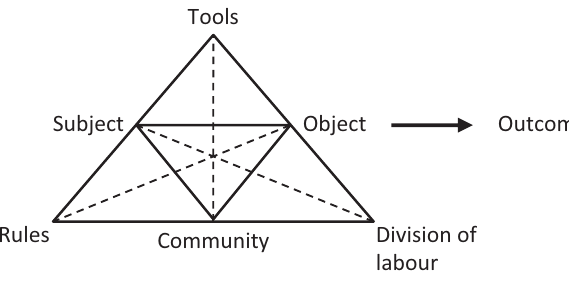
Figure 3. The basic structure of human activity. Source: Adapted from Engeström (1987).